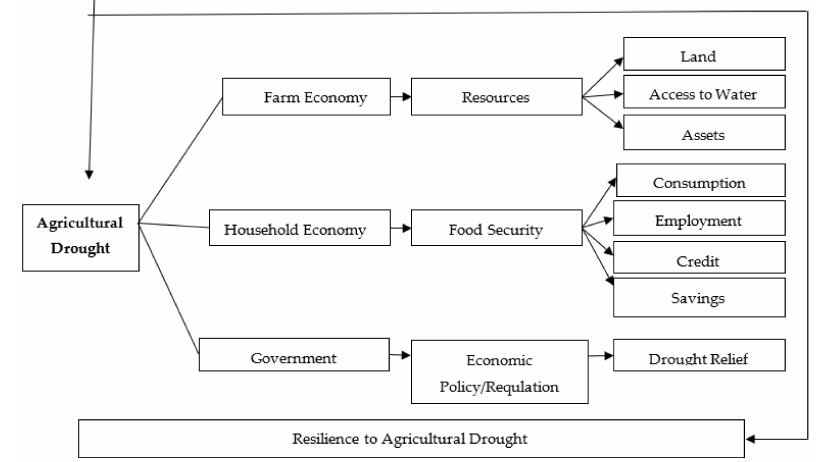
Figure 1. Conceptual framework. Source: Author’s